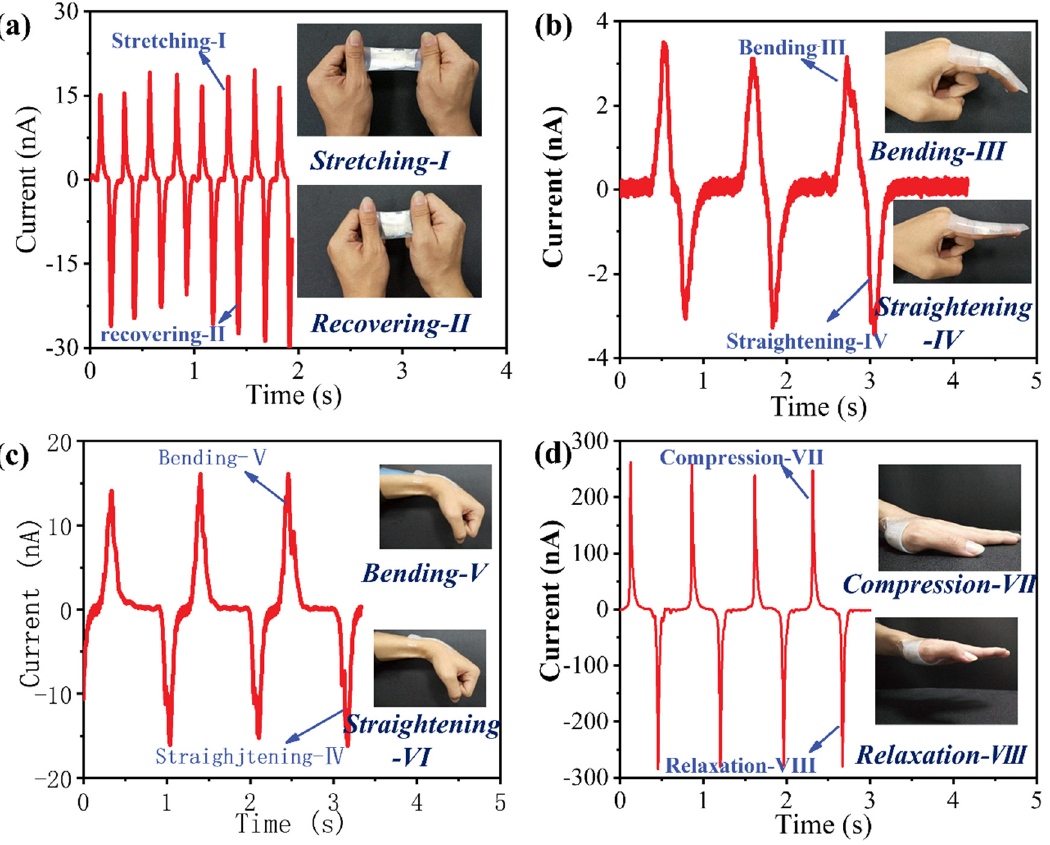
Figure 3. Applications of the flexible sensor for detecting human motions. ( a ) Detected the signals of stretching and releasing motions. ( b , c ) Detection of finger bend ( b ) and wrist bend ( c ) by attaching the sensor to the knuckle and wrist joints. ( d ) Real-time monitoring the compression and relaxation actions by mounting the sensor onto the palm.